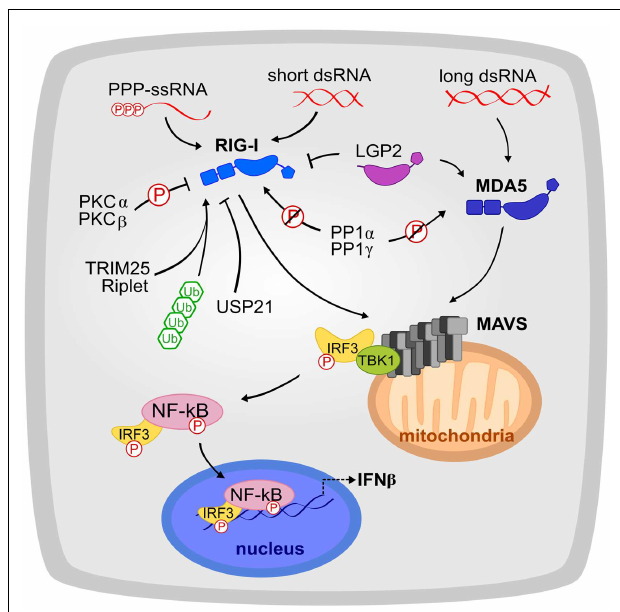
FIGURE 1 |The RLR signaling pathway is shown . RIG-I and MDA5 recognize a complementary set of cytosolic viral dsRNA ligands.Their activation is tightly regulated by phosphorylation, ubiquitination, and host proteins such as LGP2. RIG-I and MDA5 signal to MAVS, which initiates the production of interferon signaling. Circled “P” indicates phosphorylation and slashed circled “P” indicates